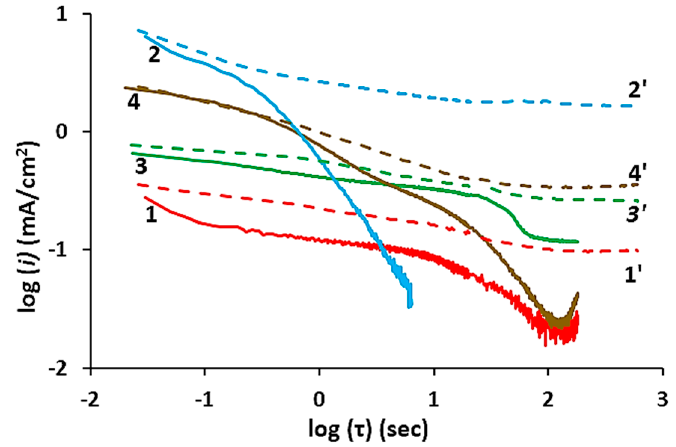
Figure 5. Transients of the anodic currents at − 0.3 V vs. SHE (1–4) and cathodic currents at − 1 V vs. SHE (1'–4') in solutions: (1,1') BB; (2,2') BB + 0.6 M NaCl; (3,3') BB + NS4 + TU; (4,4') 0.1 M NaCl. SHE (1’–4’) in solutions: (1,1’) BB; (2,2’) BB + 0.6 M NaCl; (3,3’) BB + NS4 + TU; (4,4’) 0.1 M